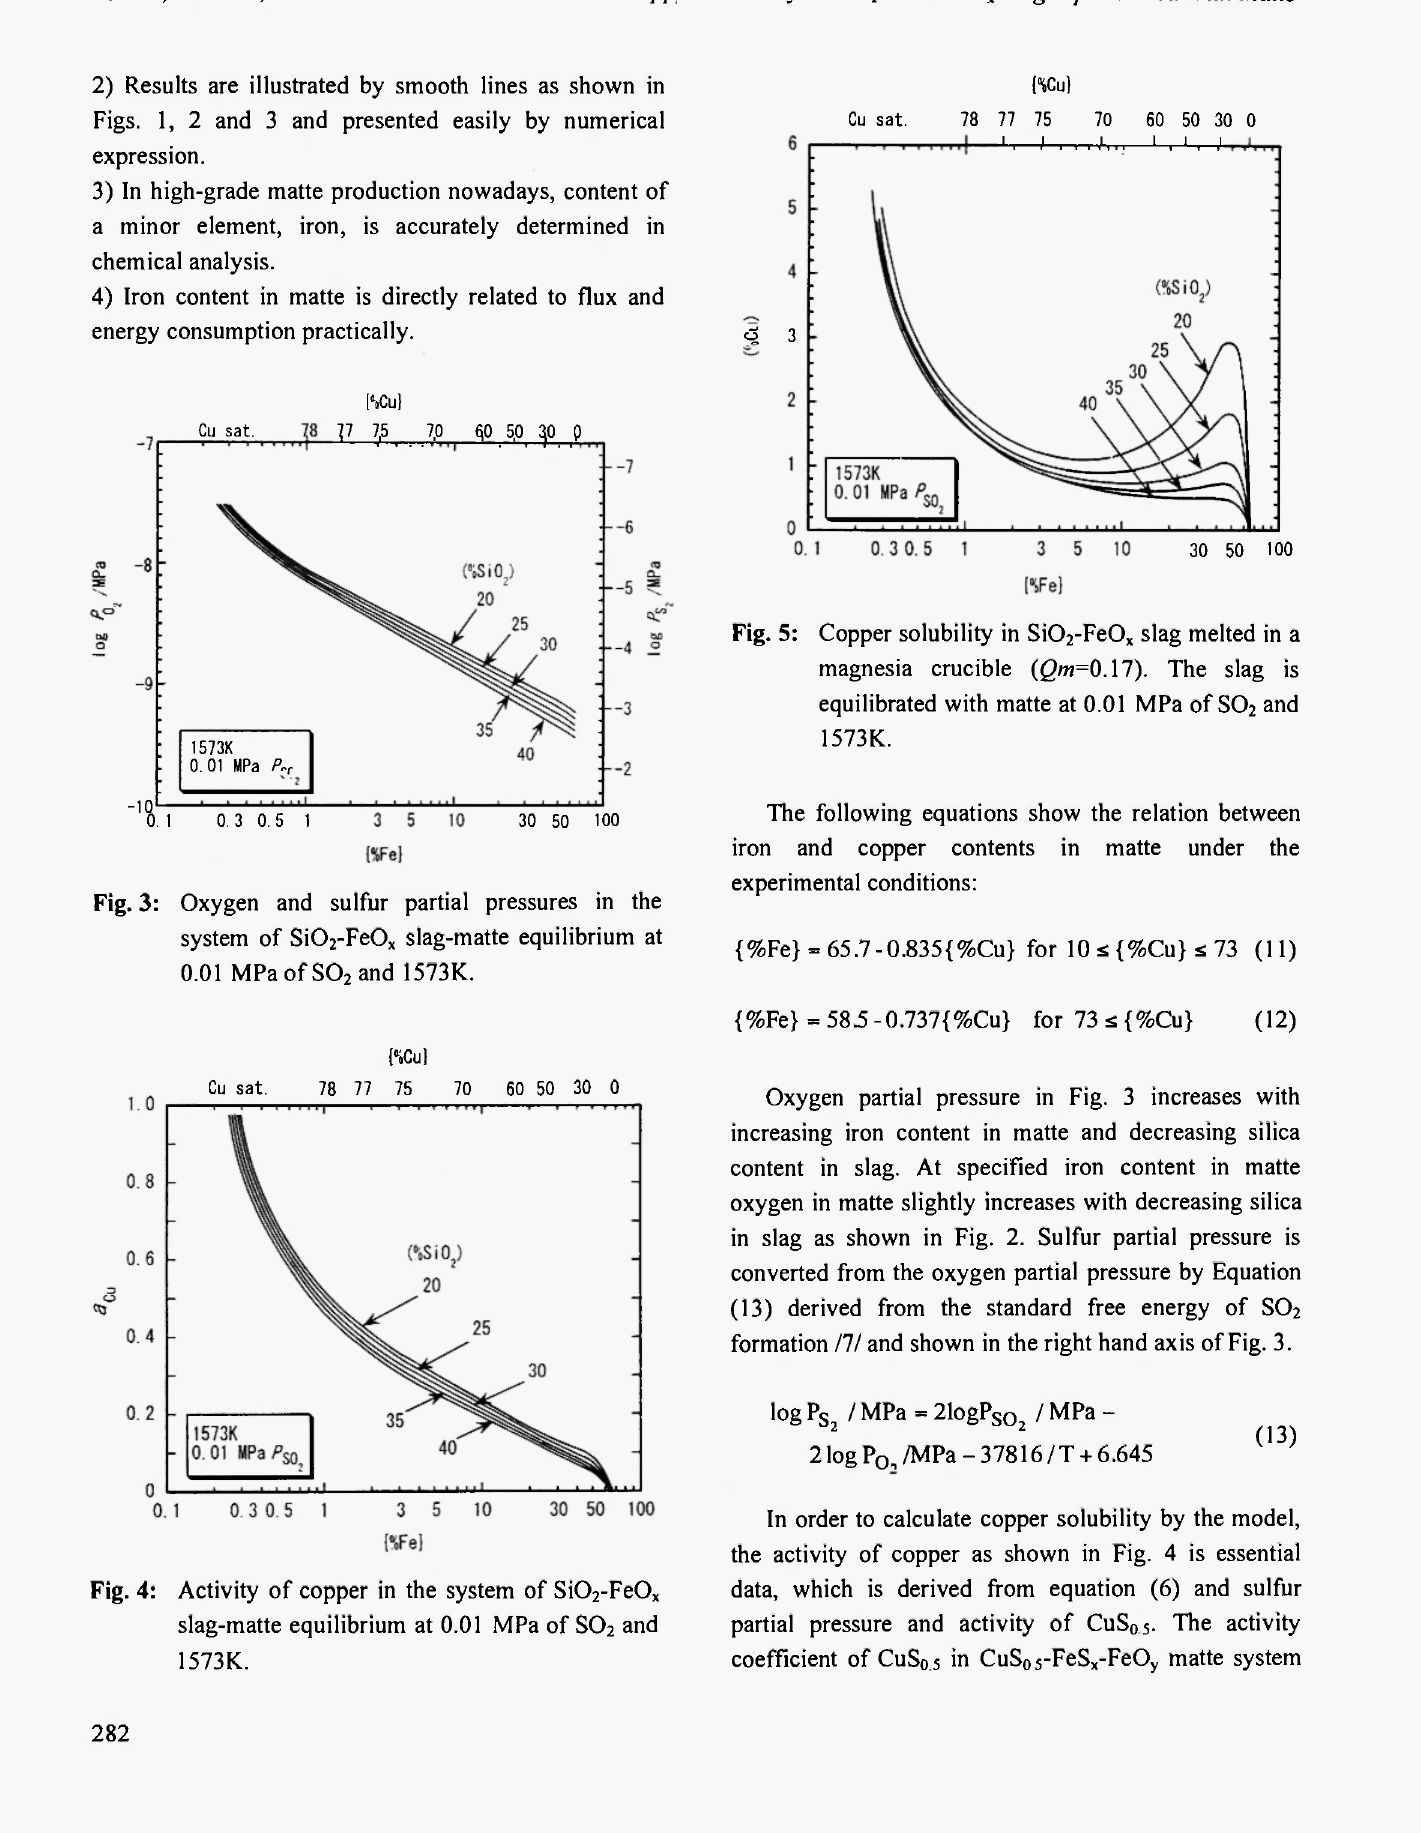
Fig. 5: Copper solubility in Si0 2 -Fe0 x slag melted in a magnesia crucible (Qm=0.17). The slag is equilibrated with matte at 0.01 MPa of S0 2 and